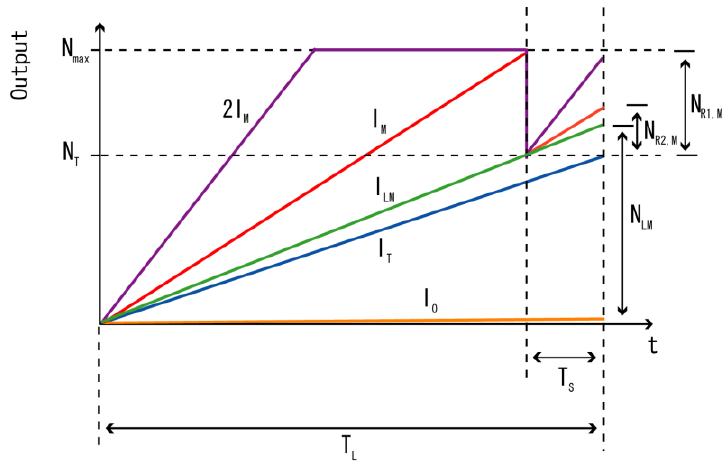
Figure 9. Charge accumulation in one